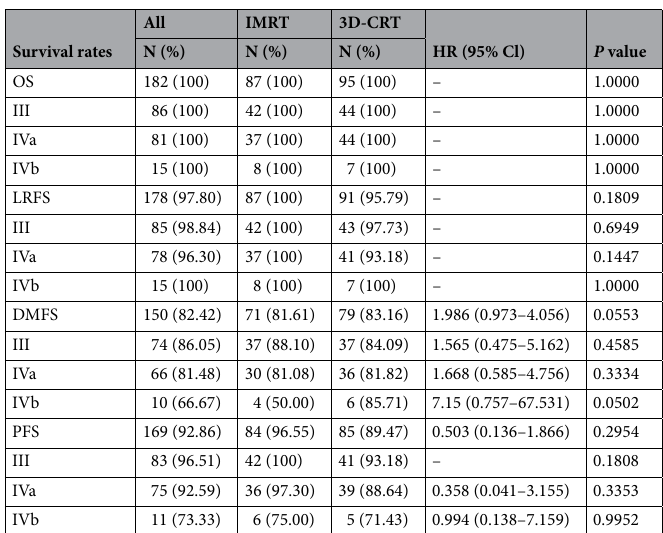
Table 5. Kaplan–Meier method compared for survival rates between IMRT and 3D-CRT. IMRT intensity modulated radiation therapy, 3D-CRT three-dimensional conventional radiotherapy, OS overall survival, LRFS locoregional relapse-free survival, DMFS distant metastasis-free survival, PFS progression-free survival. Hazard ratios (HR) were calculated with the Cox proportional hazards model, P values were calculated with the log-rank